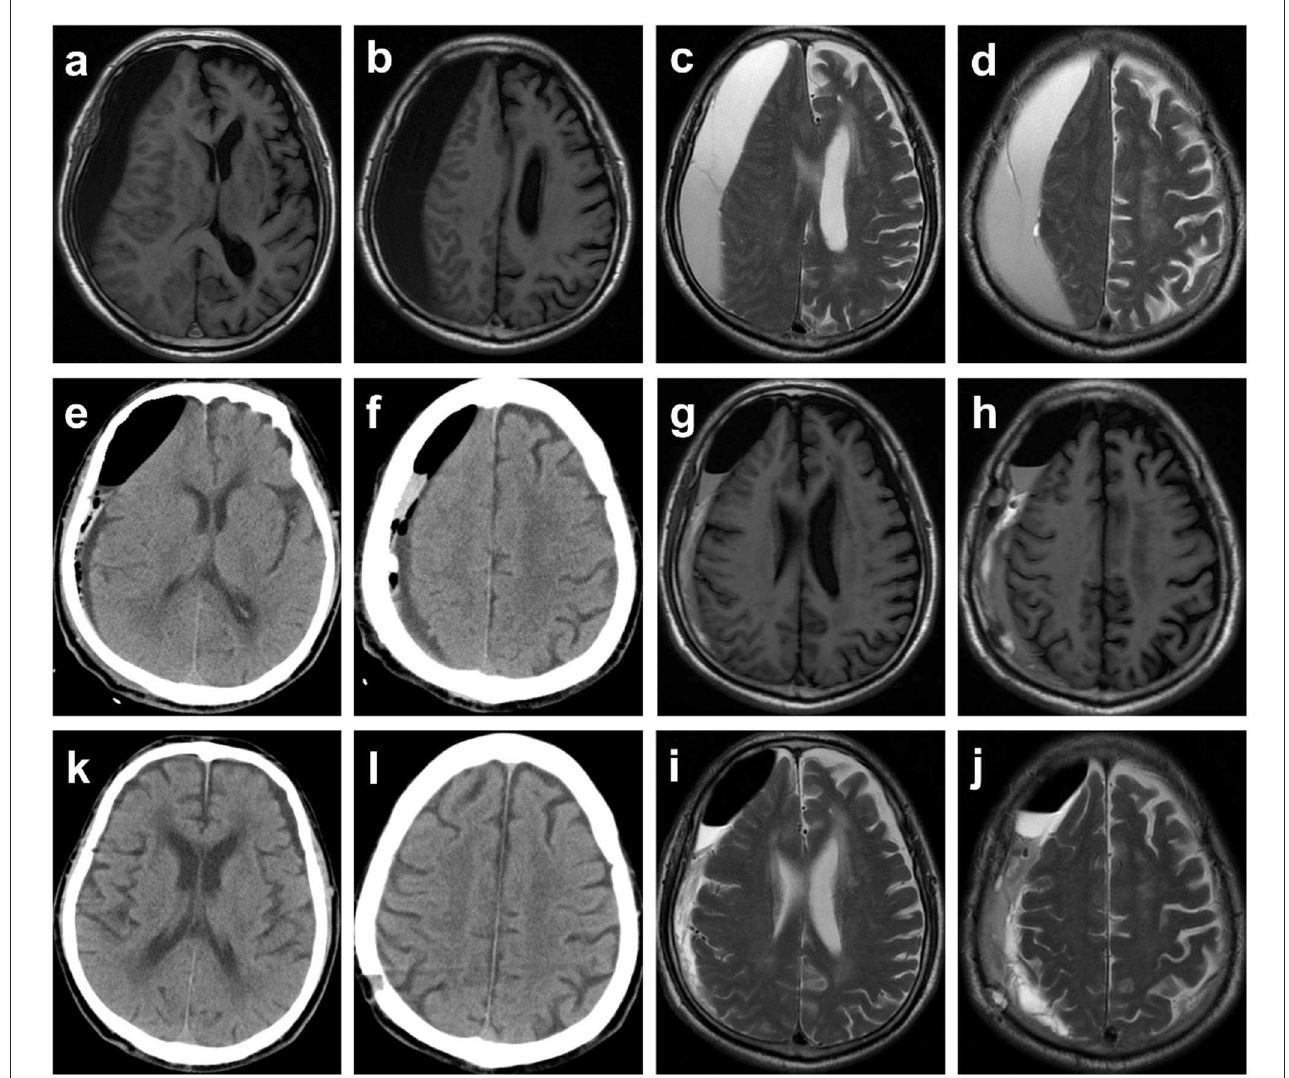
FIGURE2 Typical case 1. Images obtained from an 81-year-old man with chronic subdural hematoma (cSDH) from the MVM group. (a–d) Preoperative T1-weighted and T2-weighted MR images. (e, f) CT reexamined the day after surgery demonstrating that the midline of the brain returned to normal, yet part of blood products and air remained. The patient was asked to perform the modified Valsalva maneuver. (g–j) Postoperative (a week) T1-weighted and T2-weighted MR images. (k, l) A follow-up CT scan obtained 1 month later demonstrated resolution of cSDH, and symptoms of headache and hemiparesis were significantly